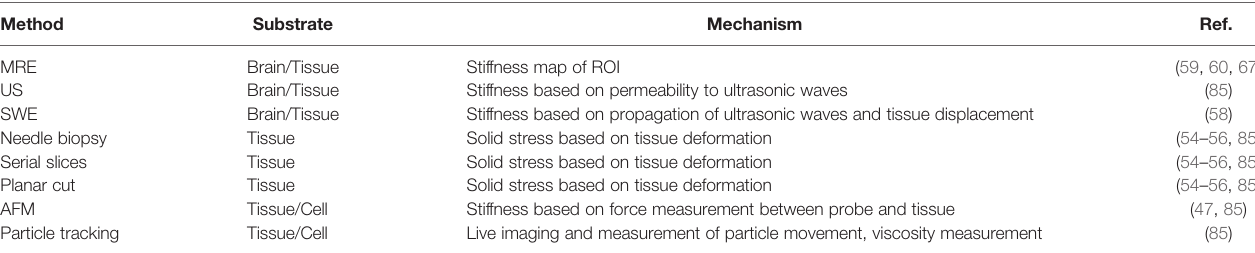
TABLE 2 | Representative Methods of Measuring Mechanical Tissue Properties in Glioma.